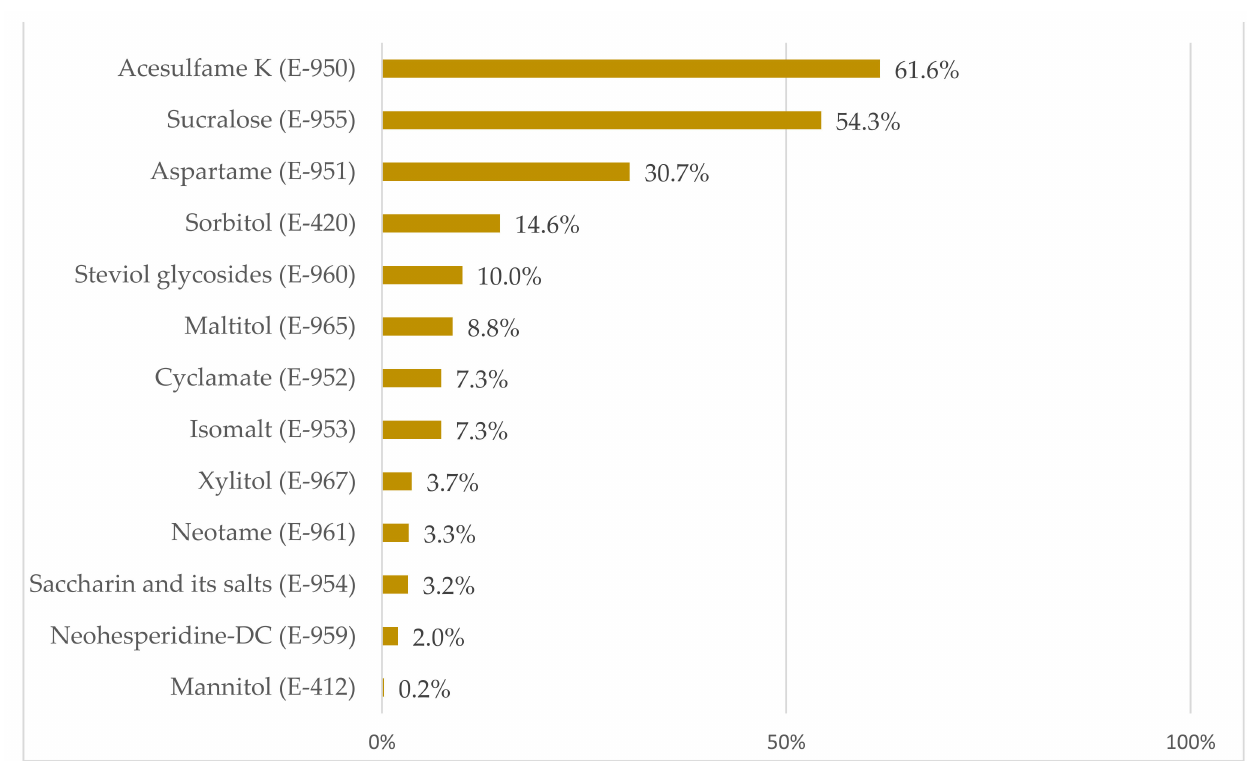
Figure 3. Proportion of low- and no-calorie sweeteners (LNCS) consumed by the Portuguese